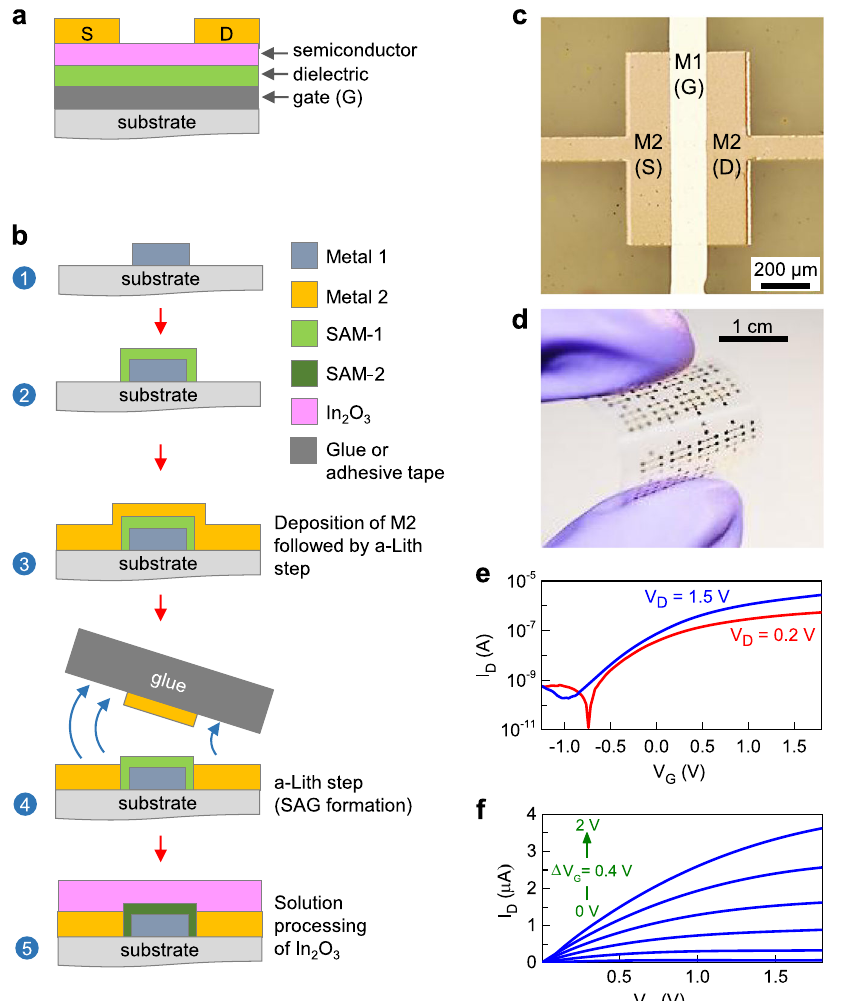
Fig. 2 Patterning of self-aligned gate thin- fi lm transistors using a-Lith. a Schematic of a conventional TFT structure characterised by signi fi cant Source-Drain/Gate (S-D/G) overlap. b Processing steps used to fabricate the self-aligned-gate transistors (SAG TFTs). Resulting devices exhibit negligible S-D/Gate overlap. c Optical micrograph of Au source and drain separated by Al gate. d Arrays of SAG TFTs fabricated by a-Lith on a – based SAG TFT with channel width and length of 1 mm fl exible PET substrate. e Transfer, and f output characteristics measured for an In 2 O 3 and 50 μ m,